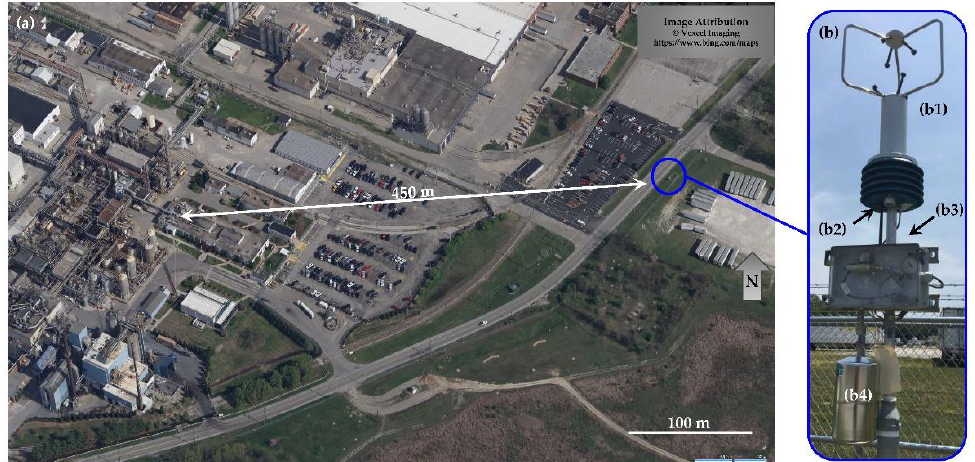
Figure 1. ( a ) Partial view of chemical facilities and sensor site (blue circle) where two SPods were located with white arrow indicating approximate direction of facility producing subsequently de- scribed SPod signal; ( b ) EPA SPod system with ( b1 ) 3-D sonic anemometer, ( b2 ) PID sensor, ( b3 ) CGS trigger system, ( b4 ) 1.4-L CGS.